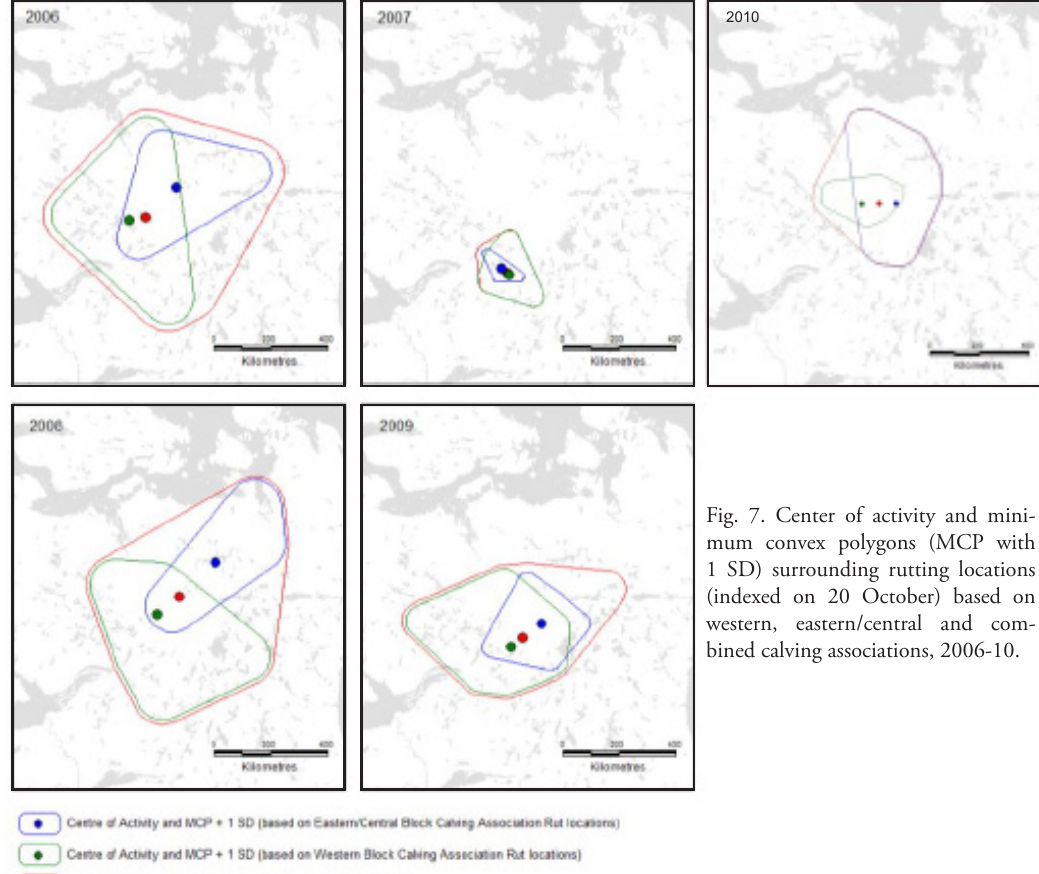
Fig. 7. Center of activity and mini- mum convex polygons (MCP with 1 SD) surrounding rutting locations (indexed on 20 October) based on western, eastern/central and com- bined calving associations,